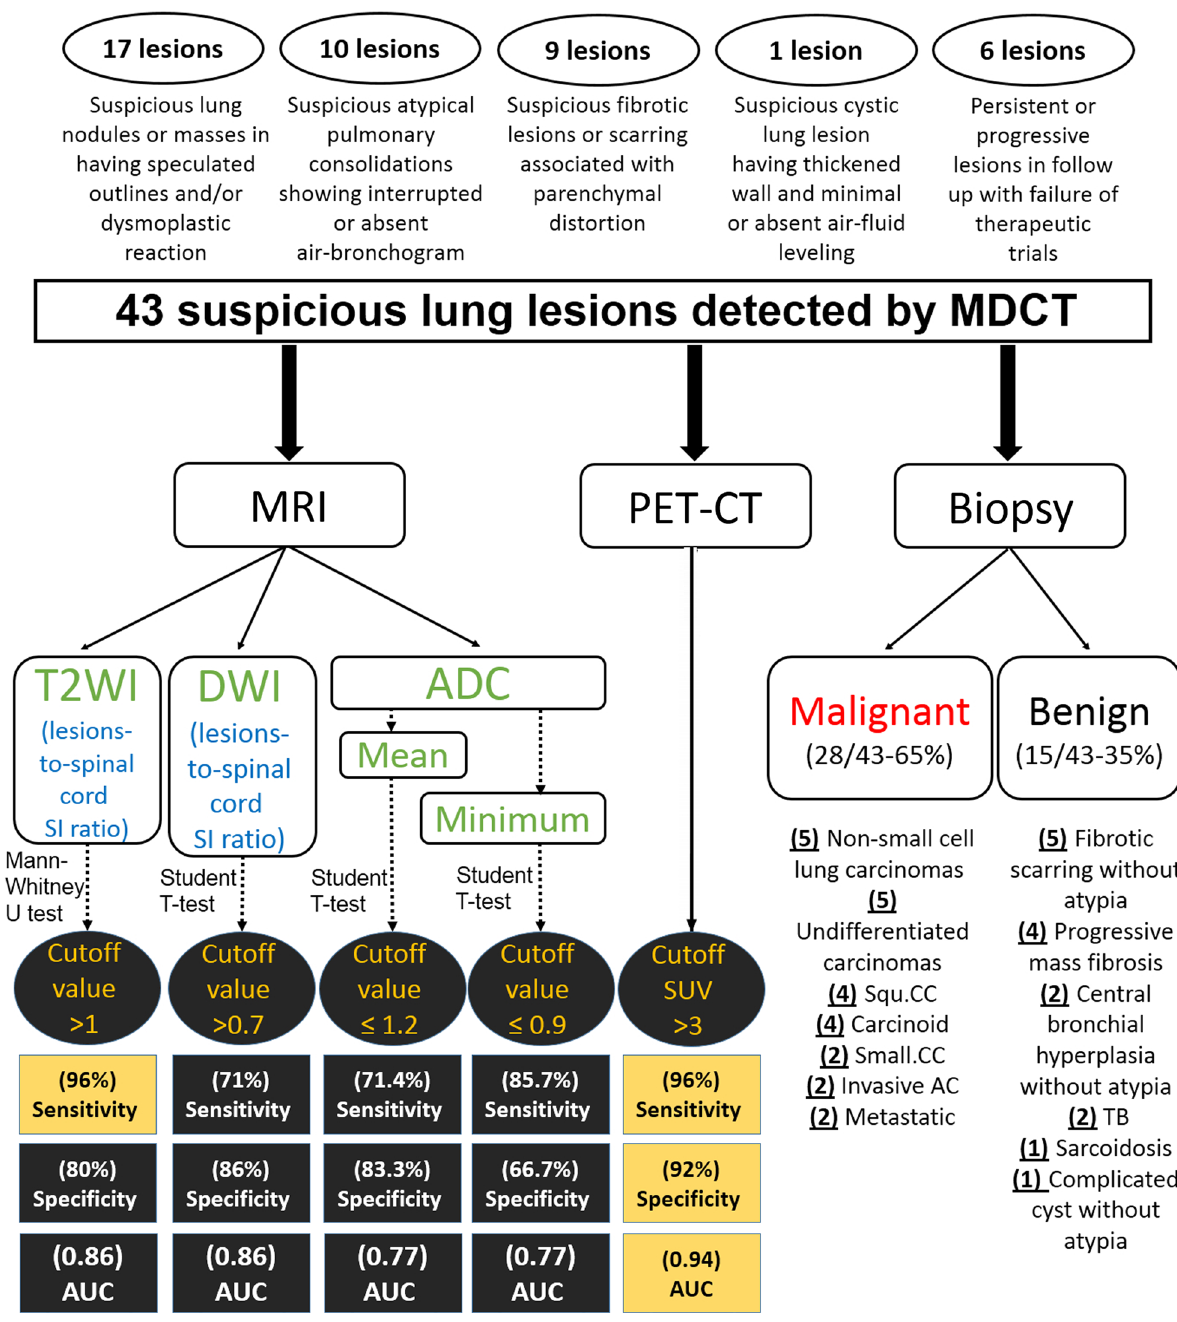
Fig. 1 A flow diagram is demonstrating the study design, methodology, and brief